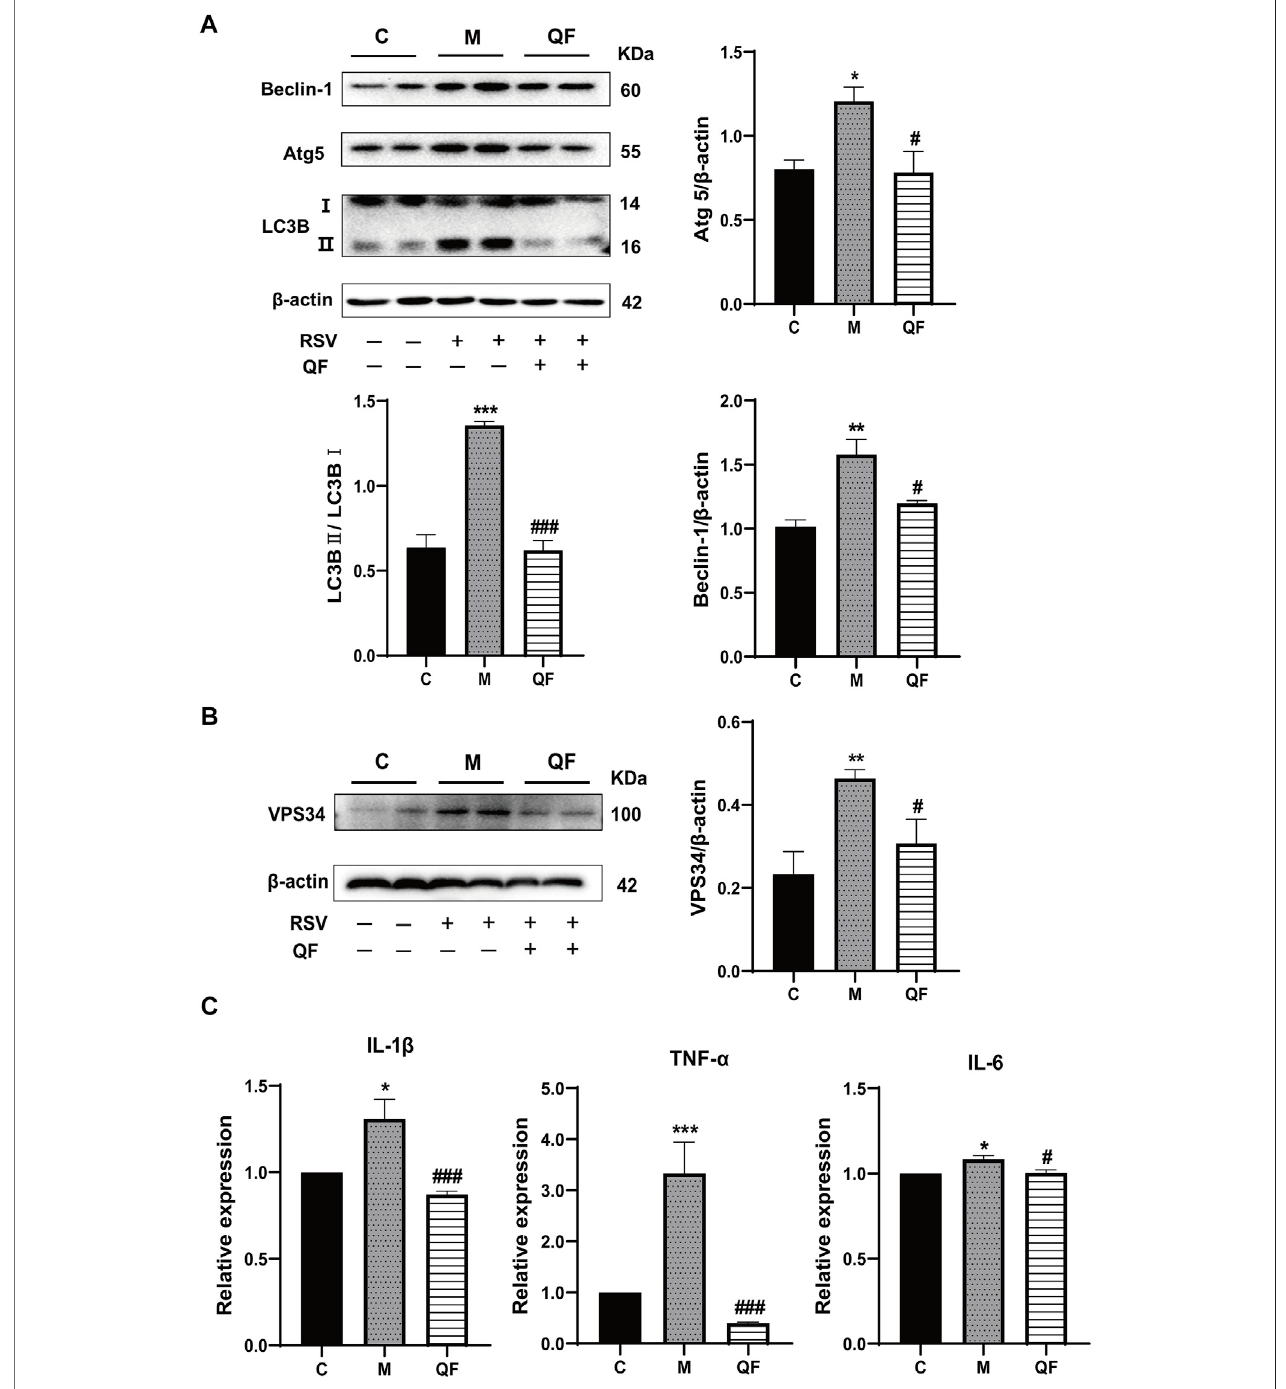
FIGURE 7 | Effect of QF on DAG-induced autophagy and in fl ammation in lung tissues of mice with RSV-induced lung in fl ammation. (A) Protein expression of Beclin-1, Atg5, LC3B (I, II), and β -actin in control (C), model (M), and therapy (QF) groups. Densitometry values of Beclin-1 and Atg5 were normalized against β -actin to determine relative protein expression values. Thedensitometry valueofLC3BIIwasnormalizedagainst LC3BI. Values areexpressed asmean ± SEM( n (cid:1) 3;*compared with control group, # compared with model group, * p < 0.05, ** p < 0.01, *** p < 0.001, # p < 0.05, ### p < 0.001). (B) VPS34 protein expression in control (C), model (M), and therapy (QF) groups. The densitometry value of VPS34 was normalized against β -actin. Values are expressed as mean ± SEM (n (cid:1) 3; * compared with control group, # compared with model group, ** p < 0.01, # p < 0.05). (C) Transcription levels of pro-in fl ammatory cytokines among control (C), model (M), and therapy (QF) groups. Values are expressed as mean ± SEM ( n (cid:1) 6; * compared with control group, # compared with model group, * p < 0.05, *** p < 0.001, # p < 0.05, ### p < 0.001). Abbreviations: QF, Qingfei oral liquid; RSV, respiratory syncytial virus.